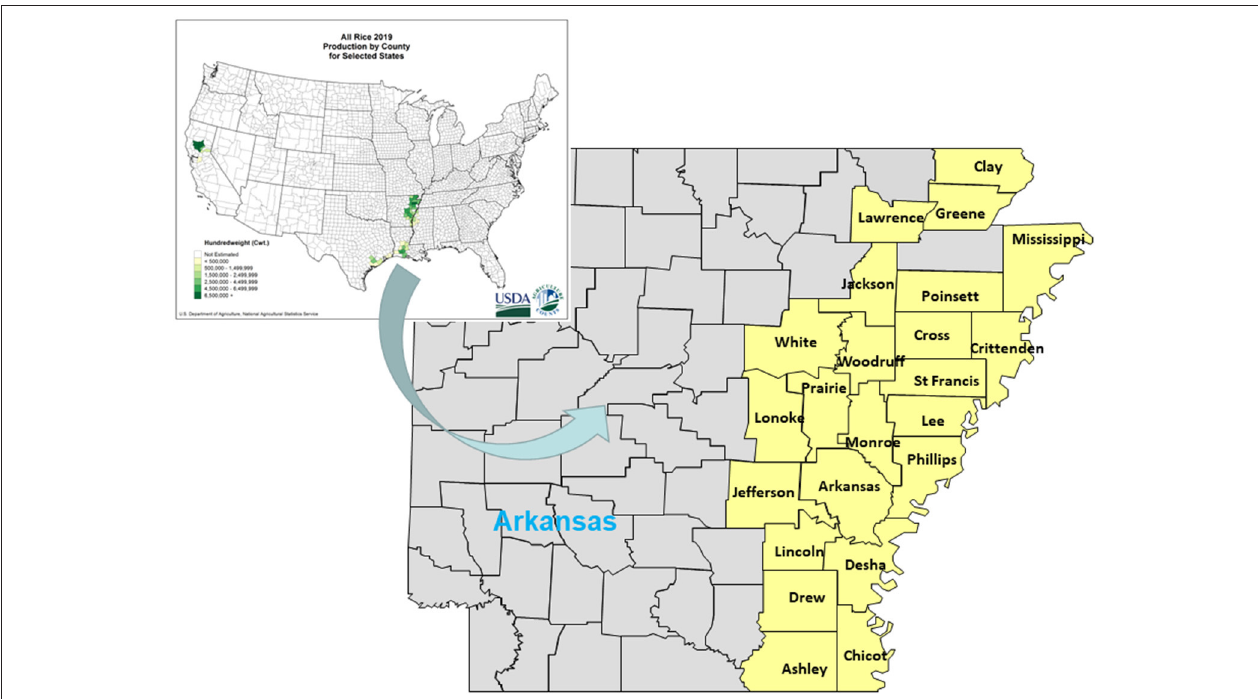
FIGURE 1 | Counties from where Echinochloa samples were collected in Arkansas, USA. Rice-producing states in the US (https://www.nass.usda.gov/